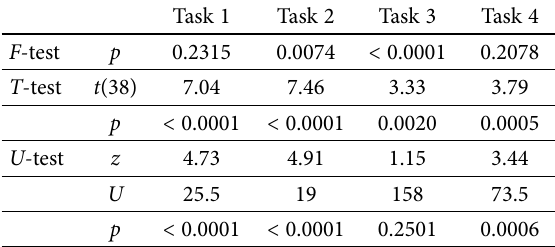
Table 18. Statistical test of the PLES and the ASA